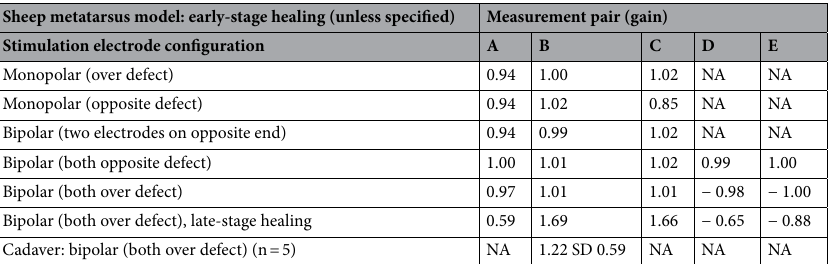
Table 4. Sheep results of Injectrode-augmented EBGS.